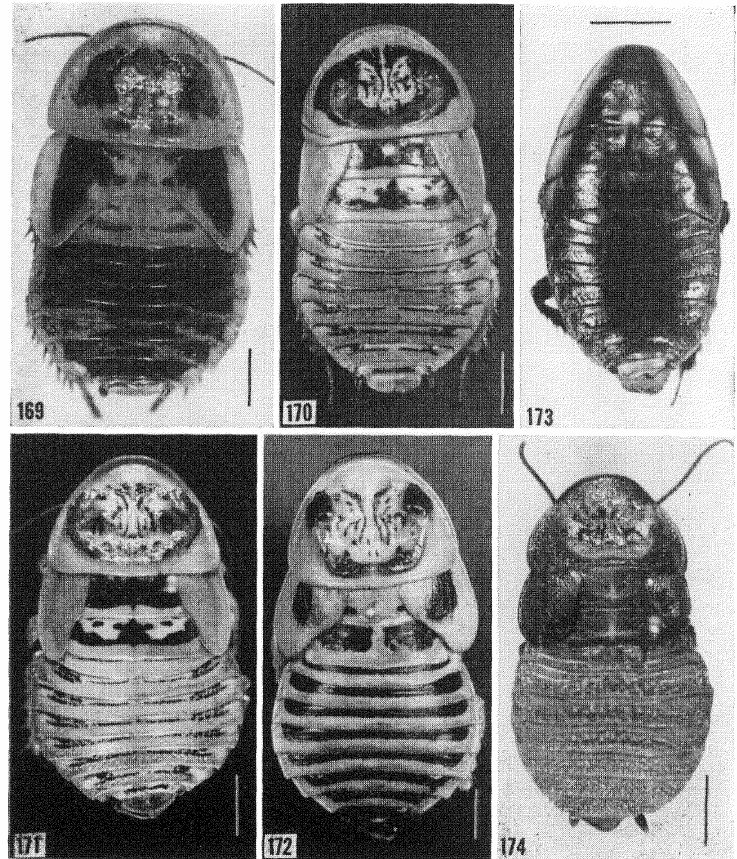
Figs. 169-174. 169. (5 MCZ). SibyllobIatta lanesthoides (Walker). Type 1621 of Hormetica adena Seudder. Belmont, Massachusetts (adventive). 170. (961 L). Parahormetica bilobata (Saussure). Lages, Brazil (det. Prineis). 171. (3 ANSP). Parahormetica bilobata. Minas Geraes, Brazil (det. by Hebard as P. tumulosa Brunner a synonym of bilobata). 172. (962 L). Parahormetica cicatricosa Saussure. Brazil (det. Prineis). 173. (972 L). Oxycercus leruaaianus Bolivar. Carpapata, Peru (det. Prineis). 174. (49 USNM). Bionoblatta itatiayae (Miranda Ribeiro). Serra do Itatiaya, Brazil (det. Gurney). (scale